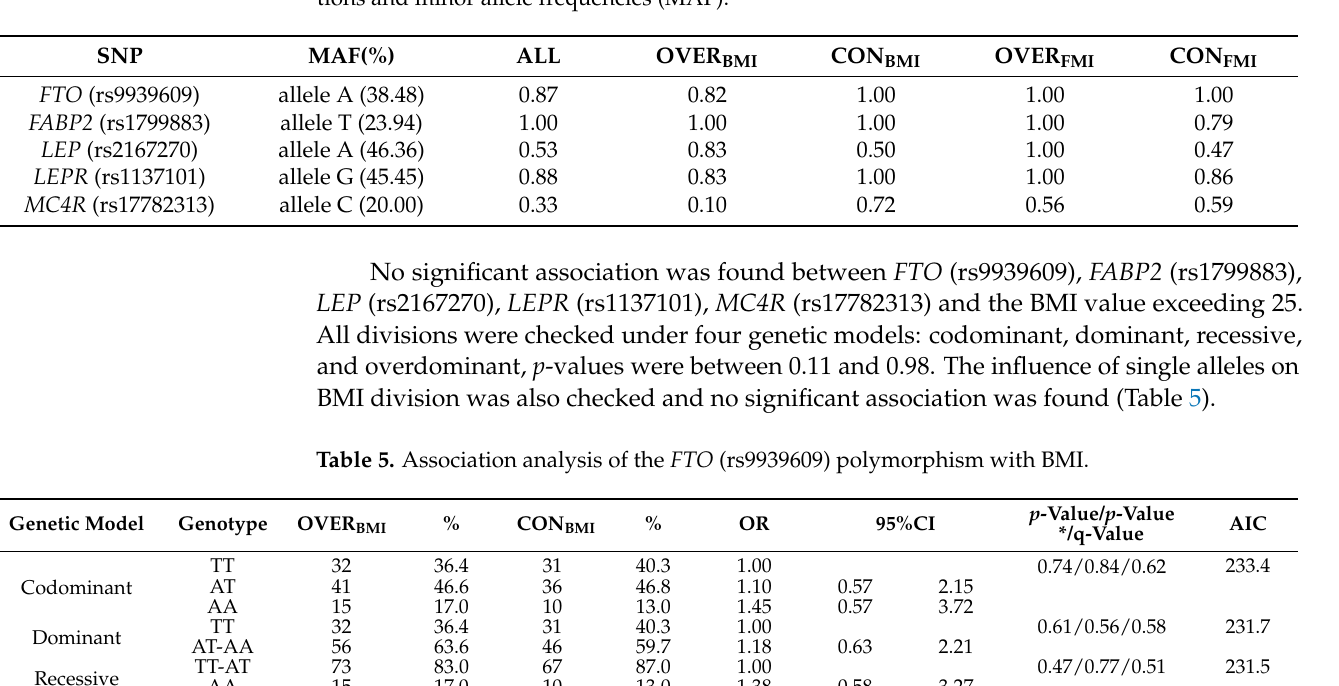
Table 4. The probability that the genotype frequencies do not differ from Hardy–Weinberg expecta- tions and minor allele frequencies (MAF).